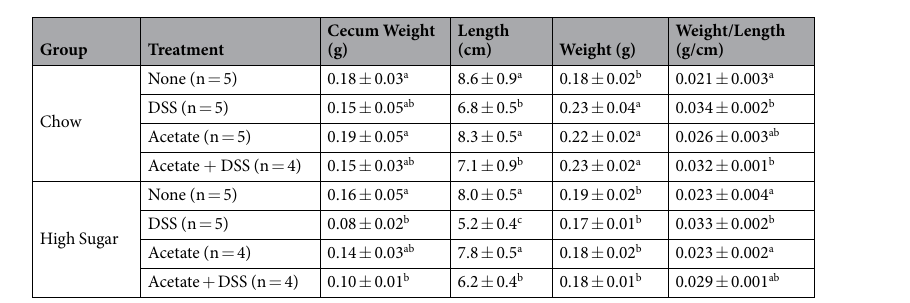
Figure 3. Mice on a high sugar diet had increased susceptibility to colitis and delayed recovery. ( A ) Disease activity index (DAI) demonstrating an increase in disease severity and lack of repair following removal of DSS in mice consuming a high-sugar diet ( * p < 0.05). ( B ) Mice on the high-sugar diet receiving oral acetate had decreased disease severity as evidenced by decreased DAI and enhanced recovery following removal of DSS ( * p < 0.05). Mice on the high-sugar diet had a significant increase in total histological score ( C ) (0–10), increased epithelial damage ( D ) (0–4), and increased lymphocyte and neutrophilic infiltration ( E ) (0–4) compared with chow fed mice. Oral acetate significantly improved total histological score and reduced epithelial damage. Representative photomicrographs of hematoxylin-eosin stained sections of colon (original magnification 200x) from chow ( F ), high sugar ( G ) and high-sugar + acetate ( H ) fed mice. Data is shown as mean ± SEM. Chow: n = 5; HS: n = 5; Chow + acetate: n = 4; HS + acetate: n = 4. ** p < 0.01; * p < 0.05.